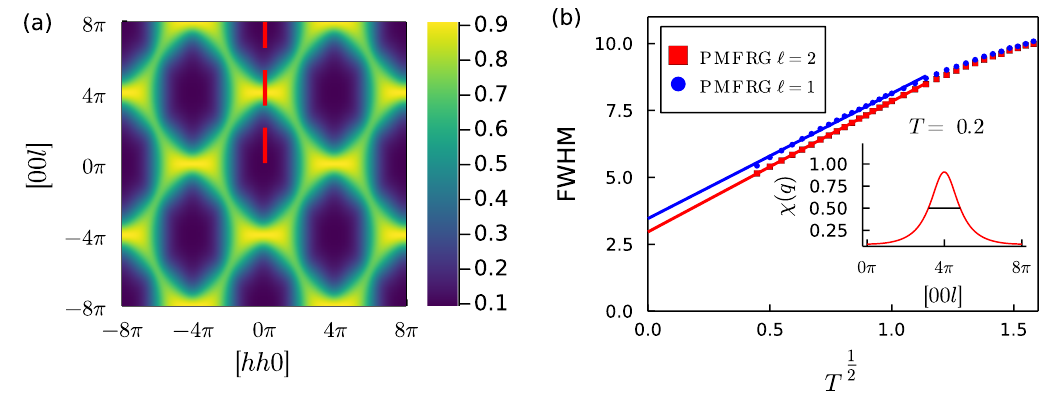
Figure 6: (a) Two-loop static susceptibility of the antiferromagnetic Heisenberg model on the pyrochlore lattice in the [ hhl ] -plane ( q (b) full-width at half maximum along of the pinch point as a function of tempera- ture. The inset shows the cut along the [ 00 l ] line of the susceptibility from